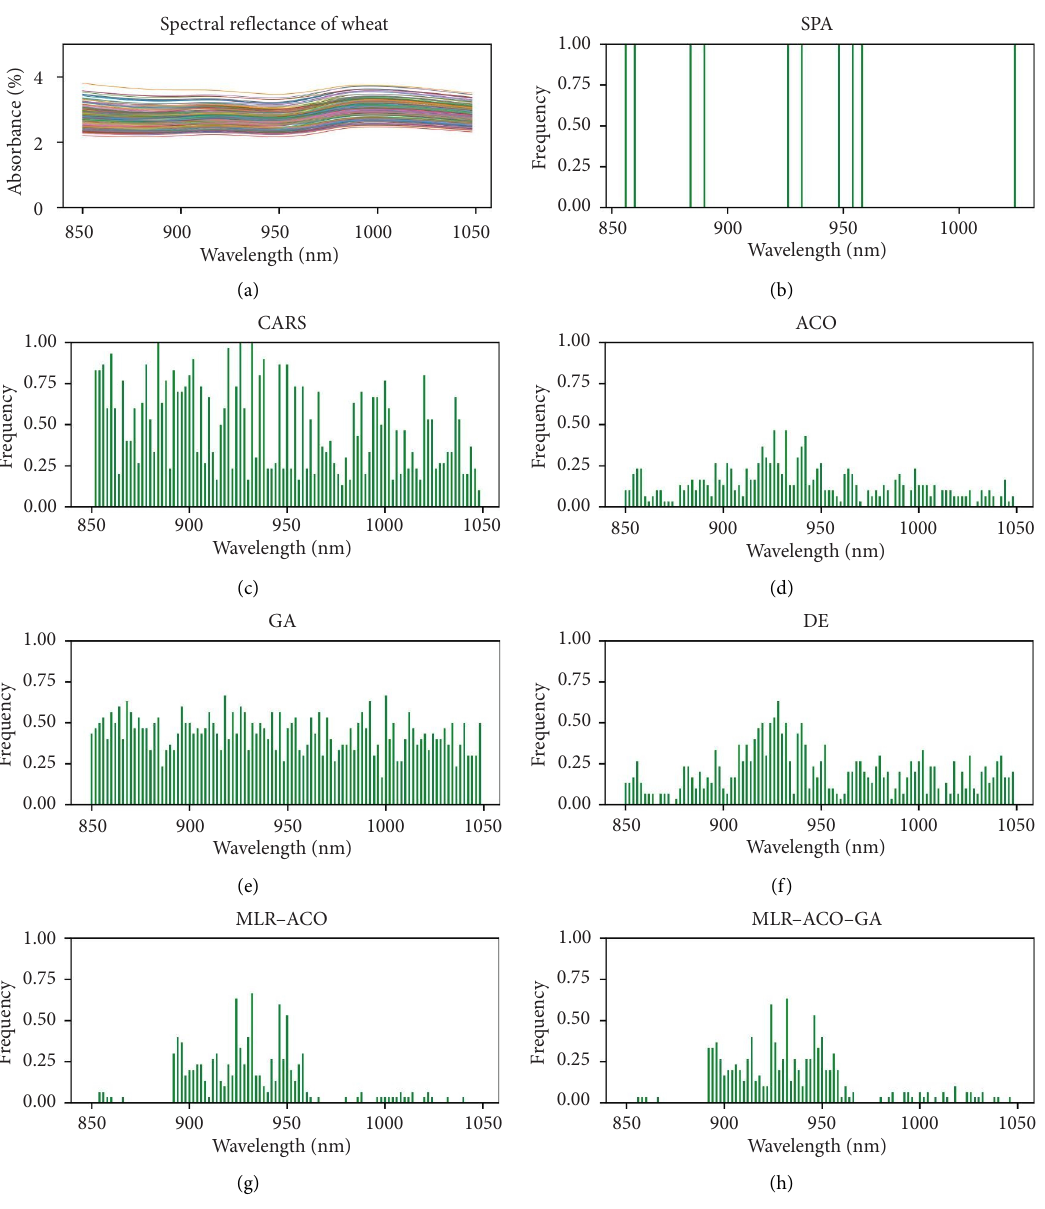
Figure 4: (a) Spectrograms of the wheat dataset; (b–h) frequencies of variables selected by diferent wavelength selection methods on the grain dataset. (b) SPA, (c) CARS, (d) ACO, (e) GA, (f) DE, (g) MLR-ACO, and (h) MLR-ACO-GA.